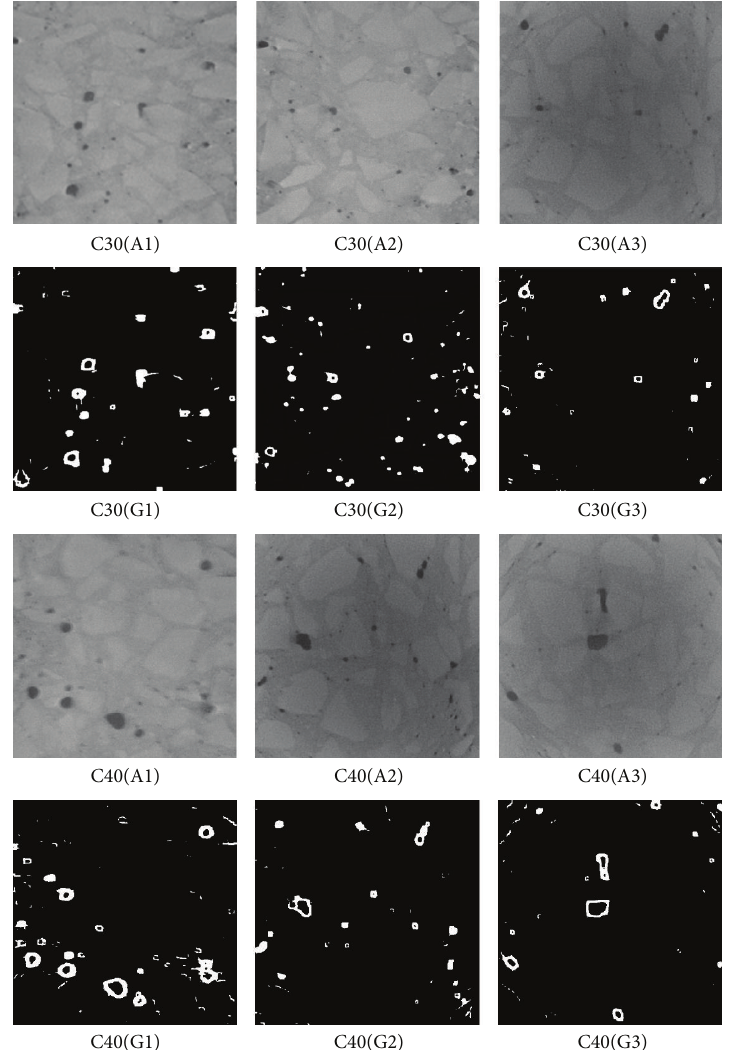
Figure 9: The segmentation performance of pore from background by applying the MNSMO